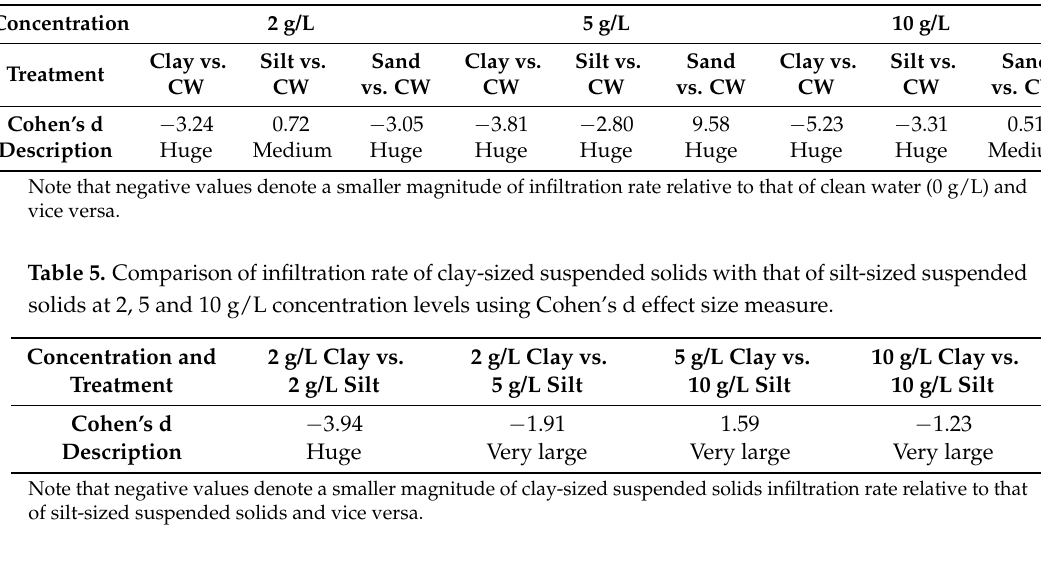
Table 4. Comparison of clean water infiltration rate with clay-, sand- and silt-sized suspended solids at 2, 5 and 10 g/L concentration levels using Cohen’s d effect size measure.